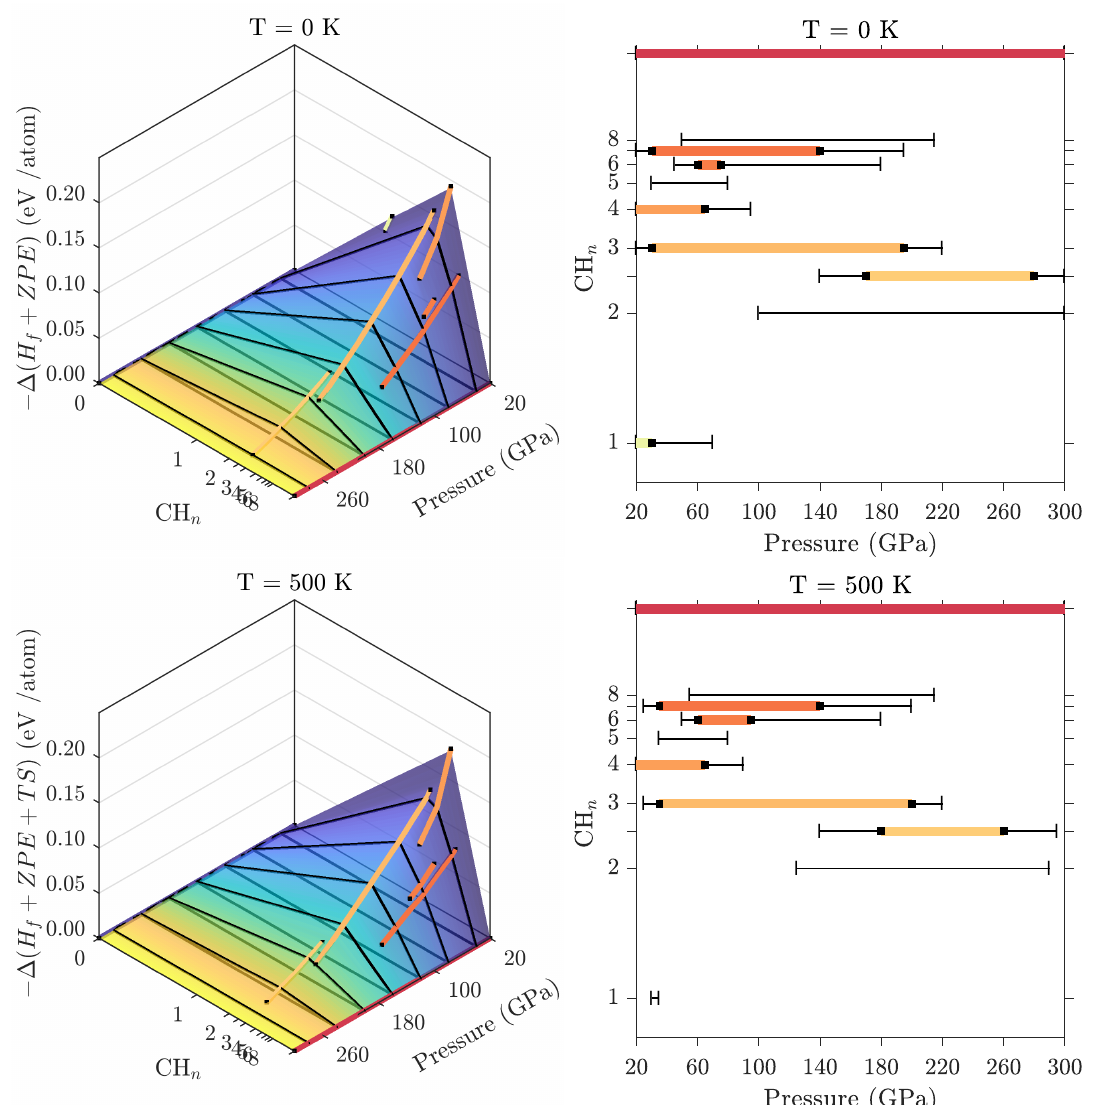
Figure 8. Convex hulls of relative free energies for C–H compounds at high pressure and resulting phase stability charts at T = 0 K (i.e., incl. ZPE, top ), and at T = 500 K ( bottom ) from the harmonic approximation. For clarity on the convex hulls, only the stable phases are indicated by coloured lines. In the stability bar charts, coloured horizontal lines represent the stability regions of different phases, with metastability (less than 10 meV/atom from the convex hull) indicated by thin black